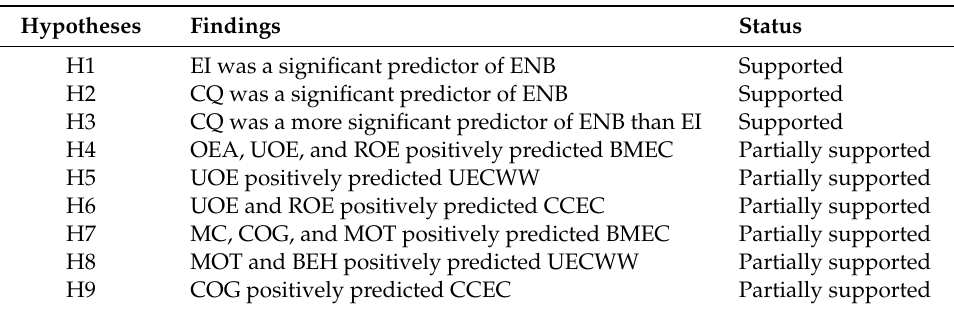
Table 8. Hypotheses final